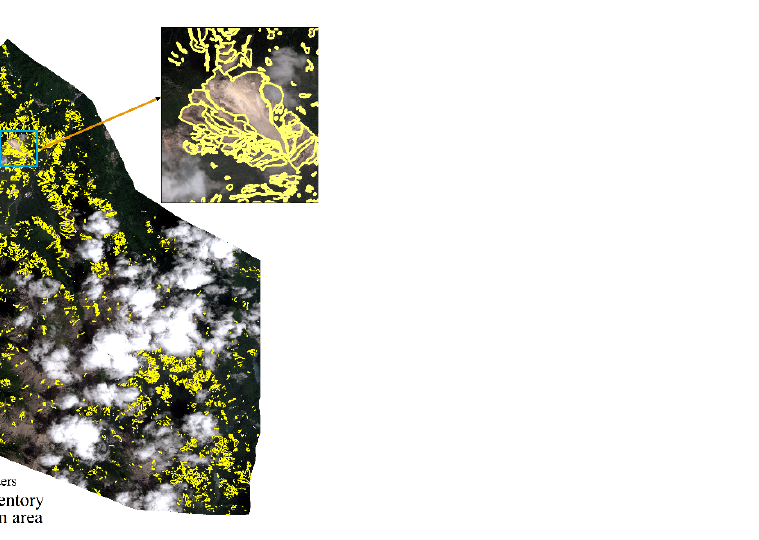
Figure 5. Landslide inventories in the Jiuzhaigou earthquake-triggered landslide dataset.